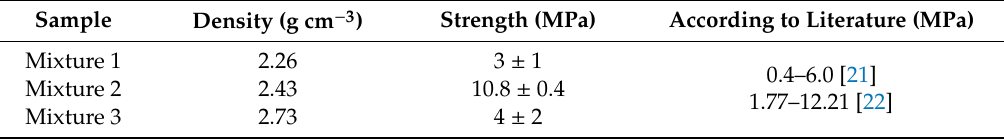
Table 4. Results of mechanical property determinations.